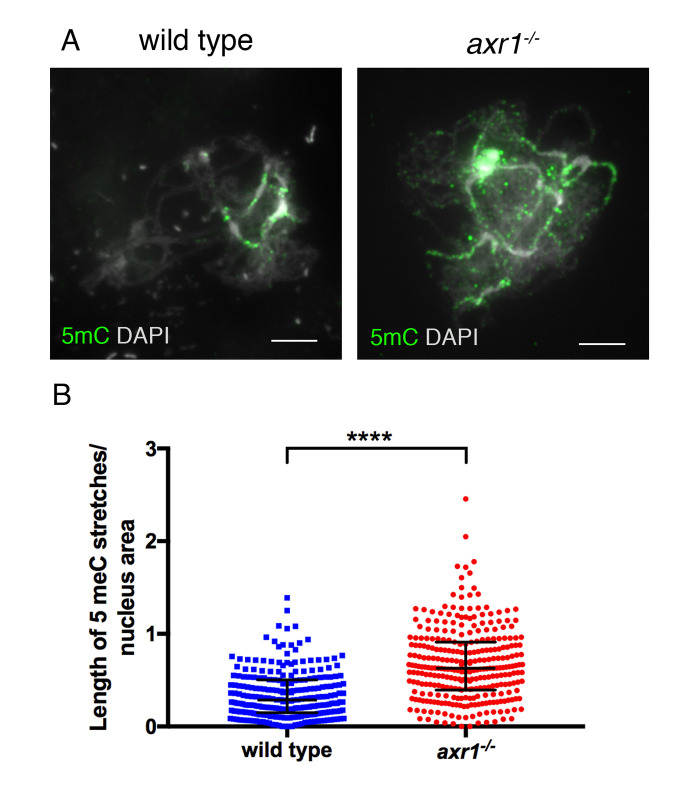
Characterization of 5-methyl-cytosine in meiocytes from wild-type and axr1-/-.Plants A: Immunolocalization of 5-methyl-cytosine (5-mC) in prophase 1 zygotene using an antibody directed against 5-mC. Scale bar = 5μm B: Quantification of the labelling of 5-mC stretches. To compare nuclei accurately, for each nucleus the length of the immunolabelled stretches was divided by the nucleus area (wild type n = 32; axr1-/- n = 30). Black bars represent the median with interquartile range. Unpaired t-test two-tailed p-value <10−10. (wt = Col-0; axr1-/- = SAIL_904_E06).